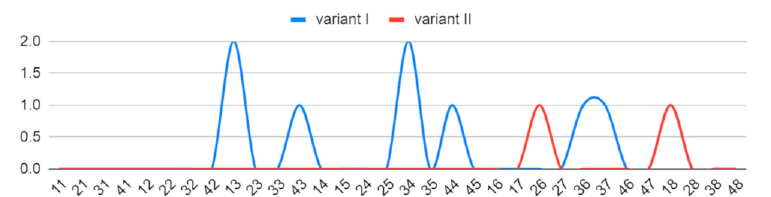
Figure 18. Chart illustrates quantity of failed power-arms according to the tooth location and PA variant. The two-digit tooth numbering system used in this article is defined by the F é d é ration Dentaire Internationale (World Dental Federation—FDI) and is designated by the International Organization for Standardization as standard ISO 3950.